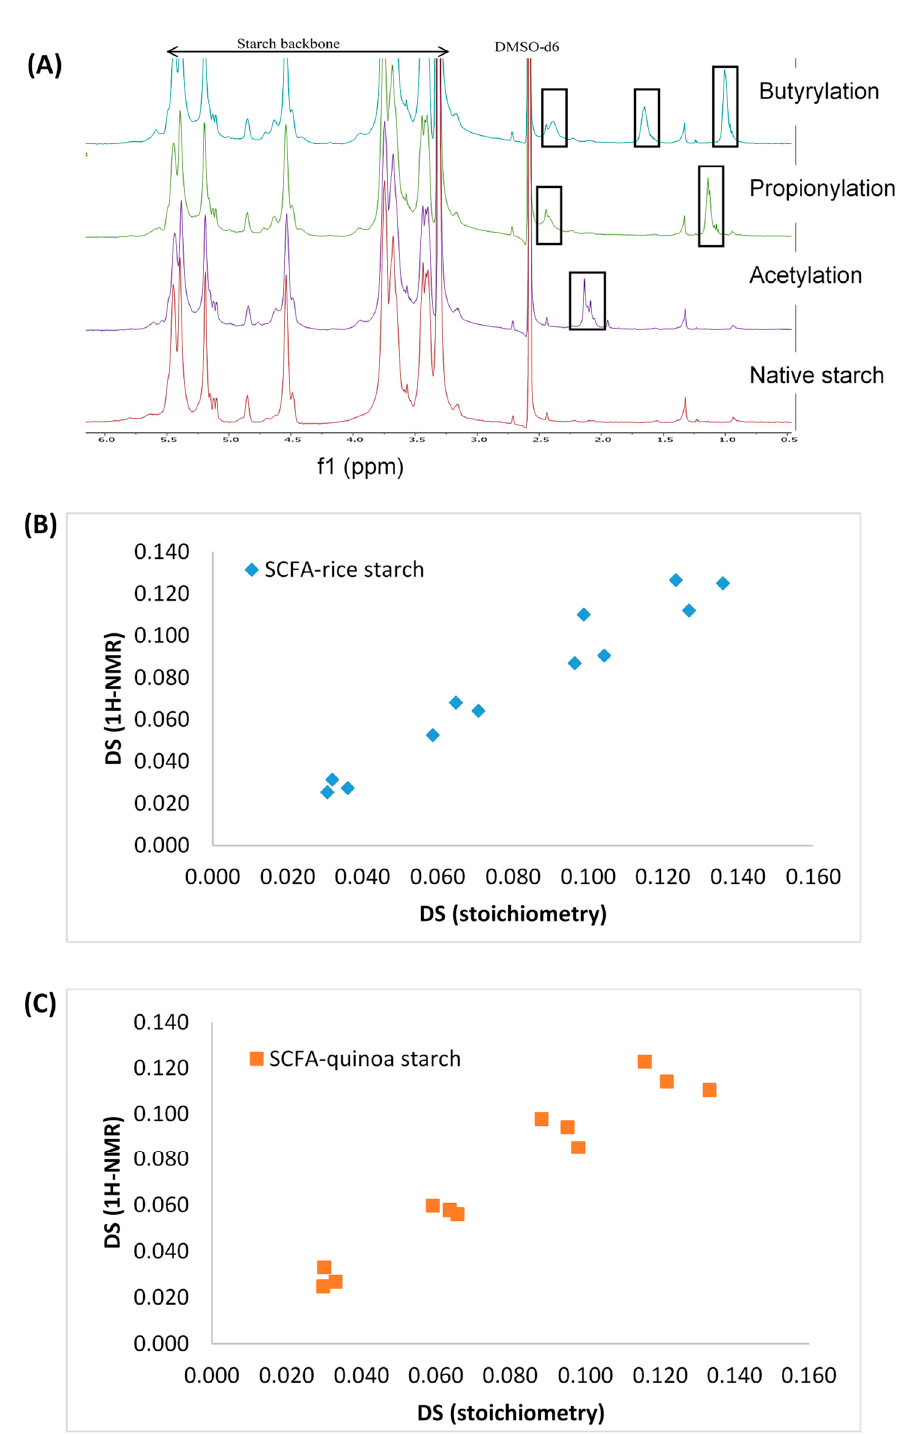
Figure 5. ( A ) Representative of 500 MHz 1 H-NMR spectra of native starch and esterified short-chain fatty acid (SCFA) starches at different acylation processes, and correlation of DS obtained from 1 H-NMR and stoichiometric calculation at a different level of modifications; ( B ) SCFA-rice starch; and ( C ) SCFA-quinoa starch.